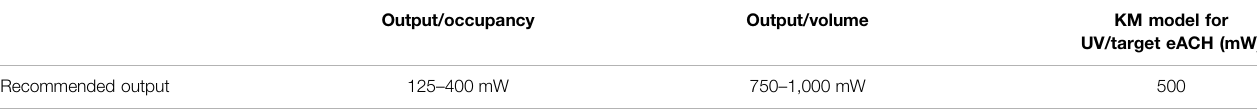
TABLE 5 | Recommended UVC output by the three approaches (UVC/occupancy, UVC/volume, and UVC/target